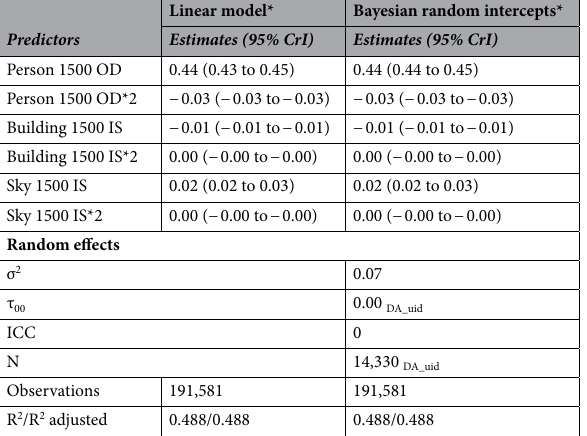
Relative importance, adjusted R 2 (95% CI)